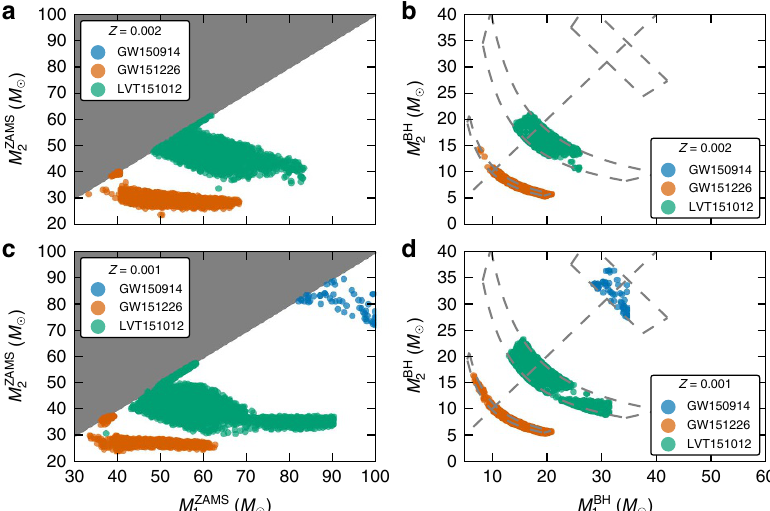
Figure 1 | Masses of BBHs observed by aLIGO and their progenitors. Each point in the plots represents one system in our simulations. ( a ) Zero-age main sequence (ZAMS) masses M ZAMS and M ZAMS for GW150914 (blue—no events), GW151226 (orange) and LVT151012 (green) progenitors at 1 2 M ZAMS Z ¼ 10% Z } ¼ 0.002 . We define M ZAMS 1 4